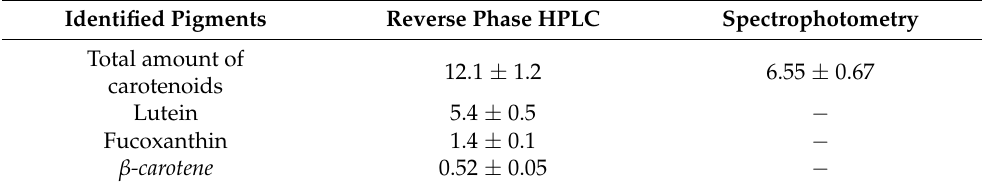
Table 3. Composition of C. vulgaris BIN biomass extract, in